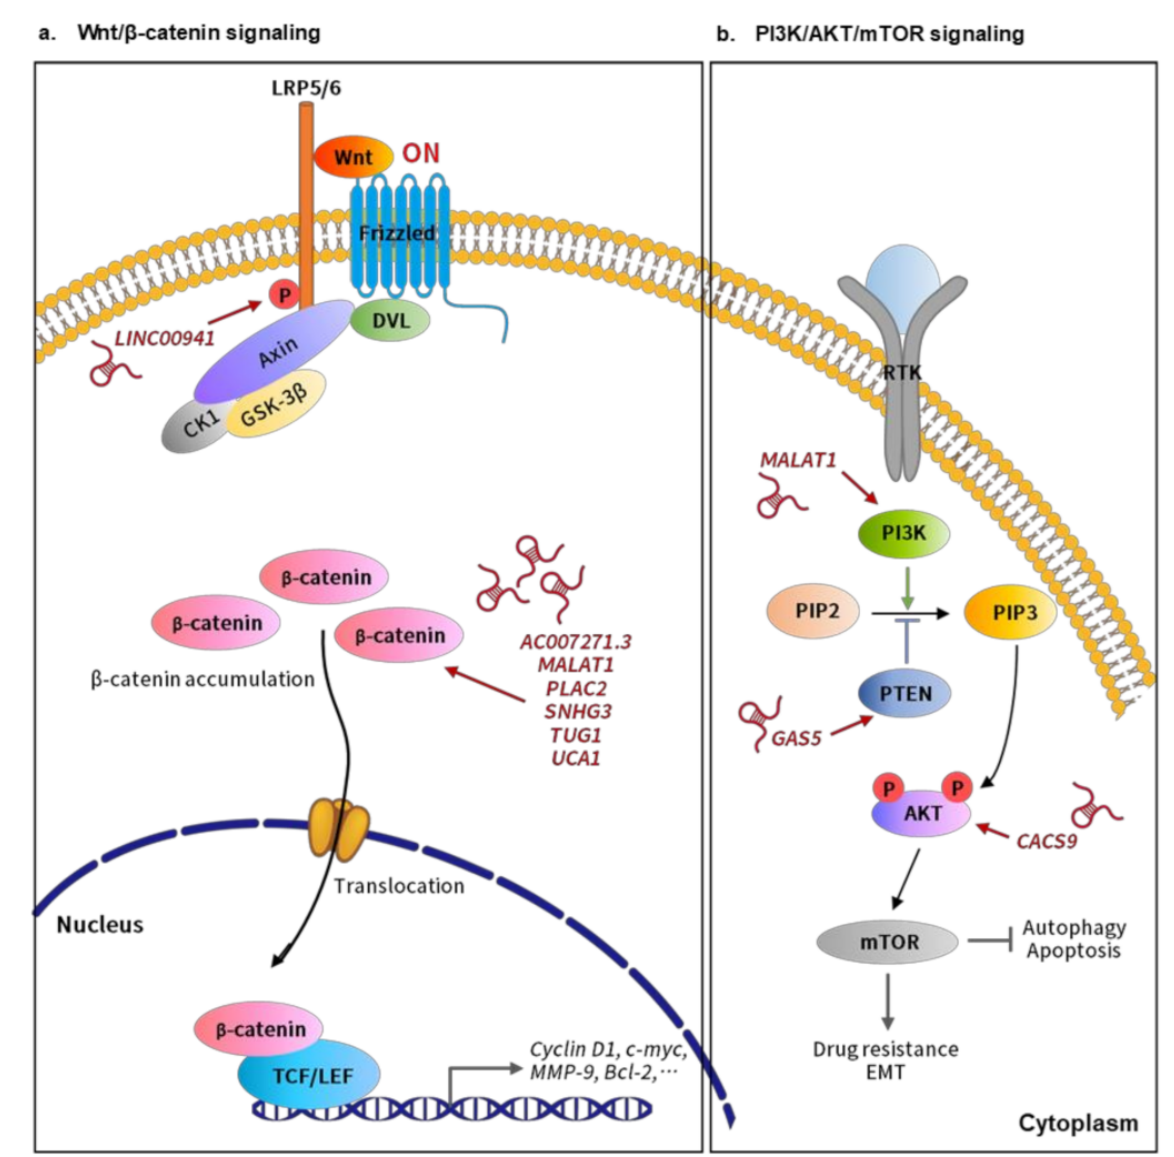
Figure 2. LncRNAs involved in the relevant signaling pathways implicated in oral cancer progression. ( a ) Wnt/ β - catenin signaling. LncRNAs, such as AC007271.3, MALAT1, PLAC2, SNHG3, TUG1, and UCA1, could activate Wnt/ β - catenin signaling mainly through inducing β -catenin accumulation. The increased β -catenin would further translocate into the nucleus and bind to LEF/TCF transcription factors to activate the downstream effectors, promoting the ma- lignant behavior of oral cancer cells. In addition, lncRNA LINC00941 could induce the expression of Caprin-2, which further promotes the phosphorylation of the Wnt co-receptor LRP6, and thereby activating Wnt/ β -catenin signaling. ( b ) PI3K/AKT/mTOR signaling. Several lncRNAs are able to target the different components of the PI3K/AKT/mTOR pathway to affect oral cancer progression. Overexpression of lncRNA MALAT1 could increase the phosphorylation of PI3K to induce PI3K/AKT/mTOR signaling, thereby promoting the EMT and cisplatin resistance of OSCC. Another lncRNA GAS5 could suppress the malignant behavior of OSCC by serving as ceRNA to sequester miR-21 and thereby reverting the miR-21-mediated repression of PTEN, a negative regulator of PI3K signaling. In addition, lncRNA CASC9 could enhance cell proliferation by inhibiting autophage-mediated cell apoptosis via inducing AKT phosphorylation and the subsequent activation of the AKT/mTOR pathway in